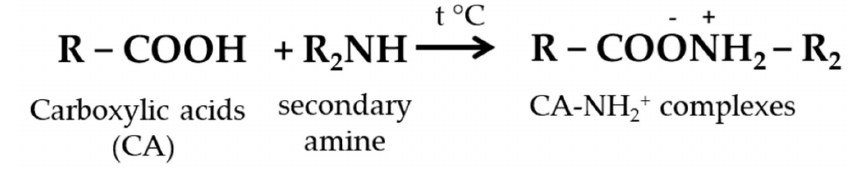
Figure 1. Scheme of amine